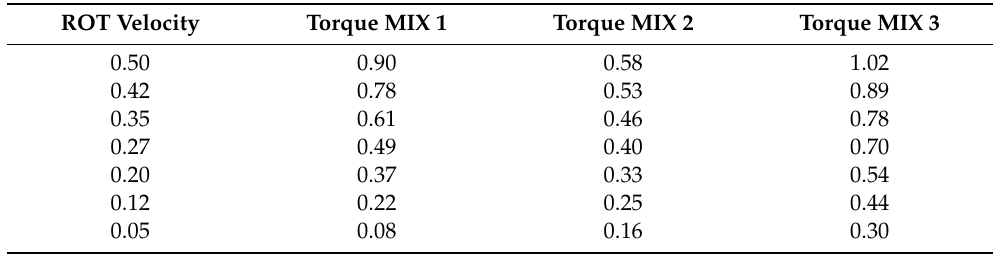
Table 9. Measured torque values in the interface rheometer for each mixture at the pre-determined rotational velocities.